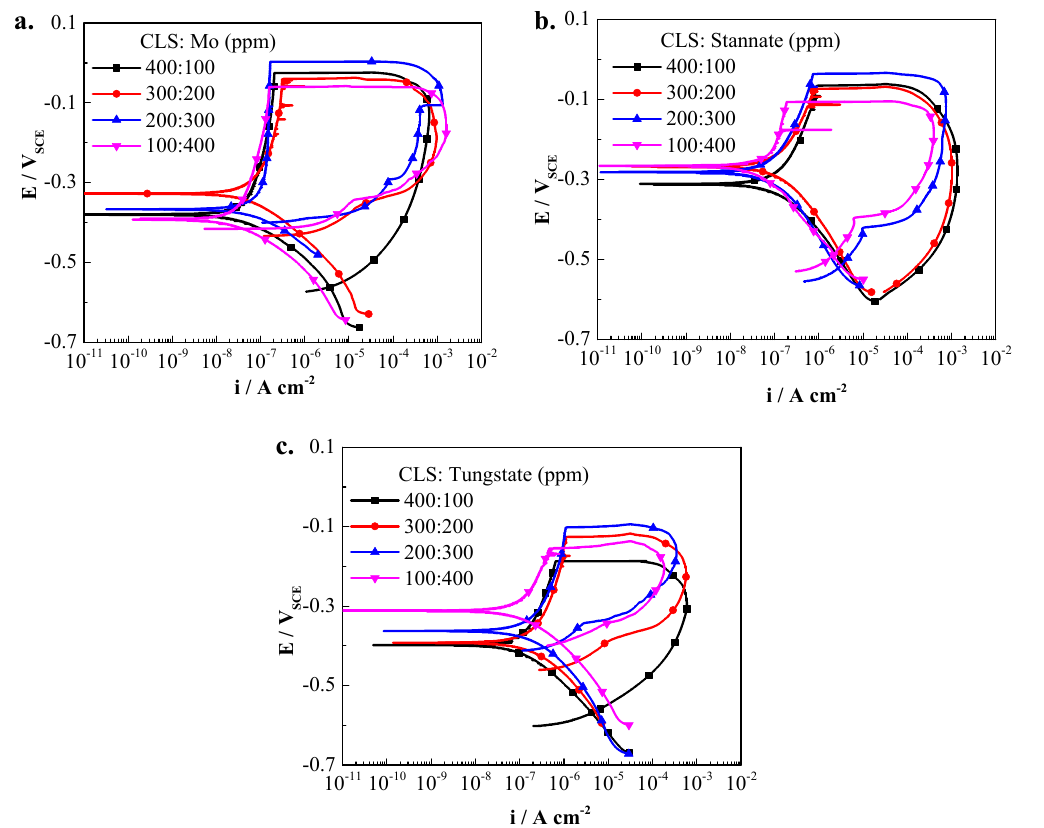
Figure 3. Polarization curves of Q235 steel in solution with CLS and inorganic inhibitors. ( a ) CLS with molybadte; ( b ) CLS with stannate; ( c ) CLS with tungstate.